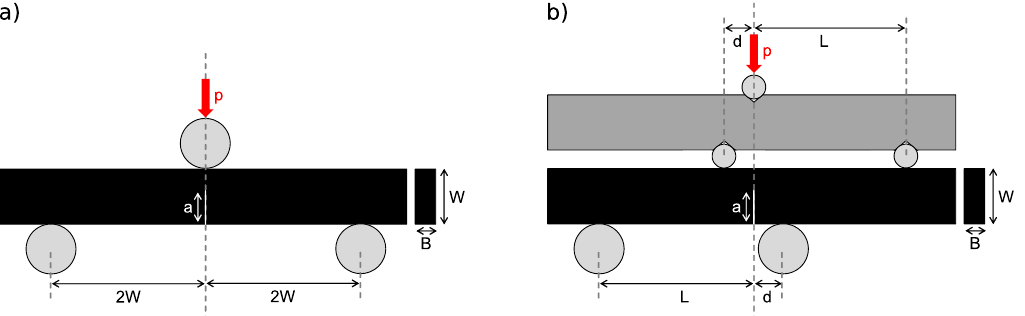
Figure 1. Test setup and definitions for determination of ( a ) K IC in a three-point-bending test ( b ) K IIC in asymmetric four-point-bending test adapted from [31].